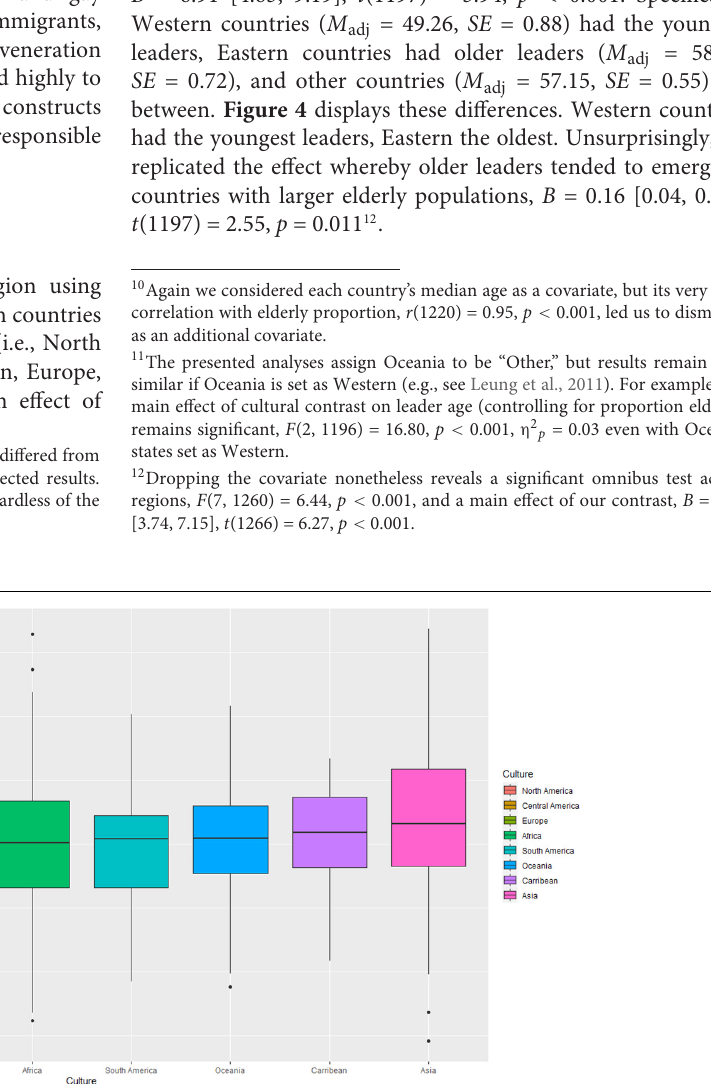
Frontiers in Psychology |